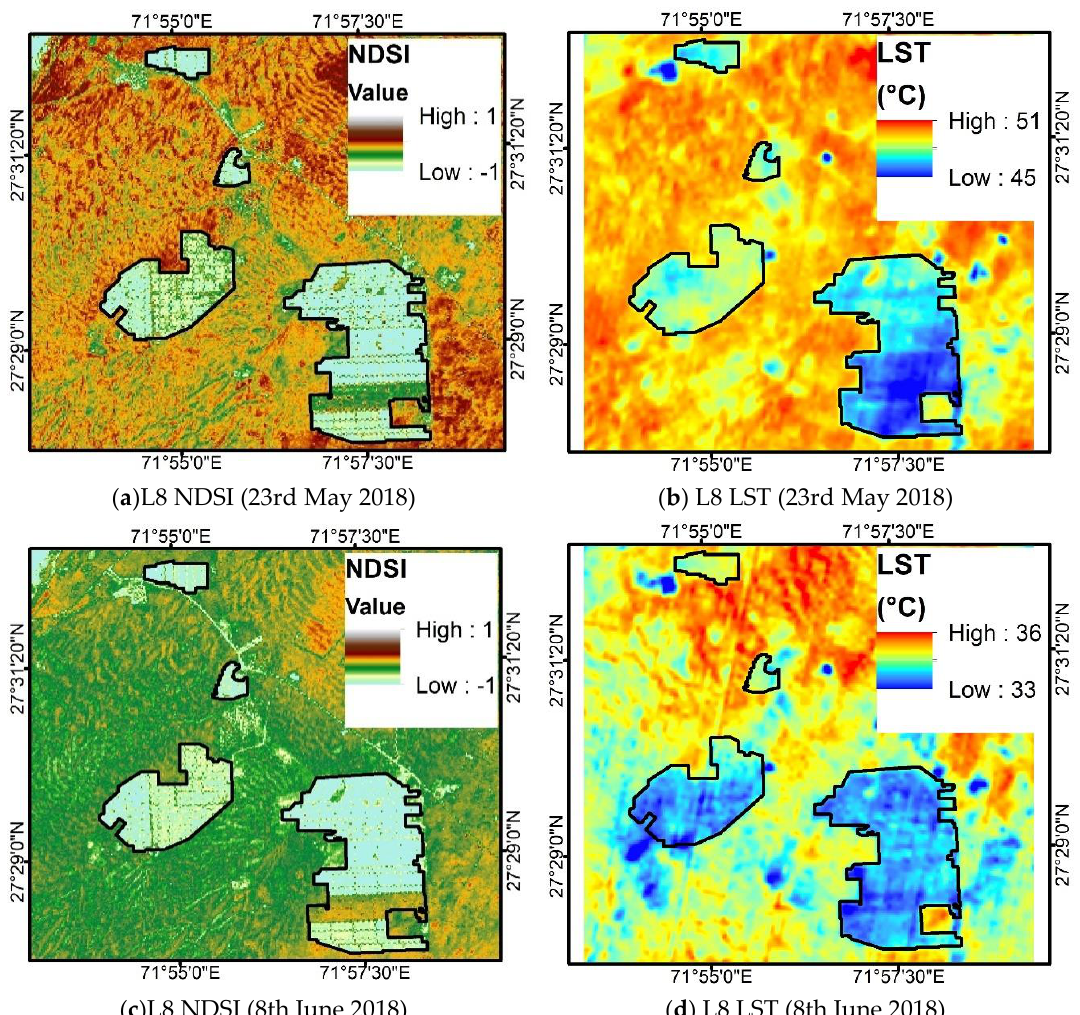
Figure 7. Visual comparison of sand deposition on the solar farm based on NDSI and LST after cleaning. The figure shows a similarity between NDSI (Figure 7( a ), 7( c )) with sand deposition variation and LST pattern of Figure 7( b ), 7( d ), respectively.